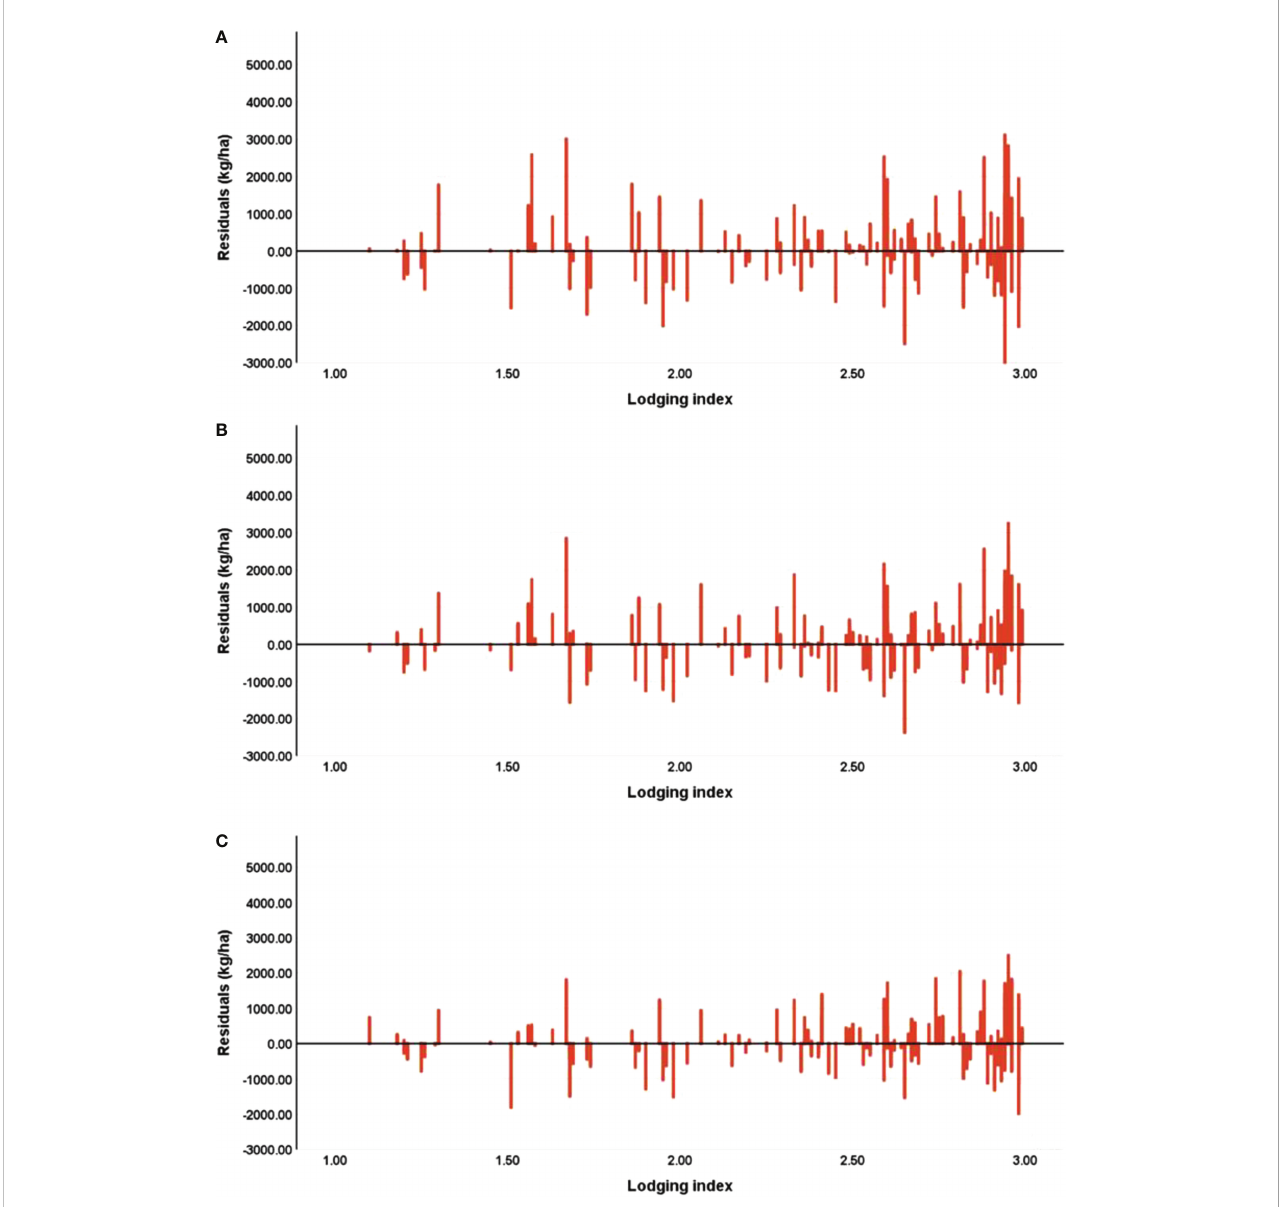
FIGURE 12 Estimation bias between measured yield and estimated yield, at the (A) tasseling stage (VT), (B) milking stage (R3), and (C) denting stage